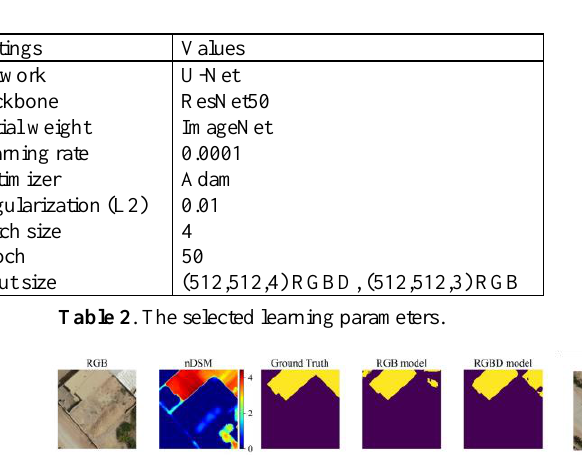
Table 1 . Tests on validation data to find the optimum hyperparameters.